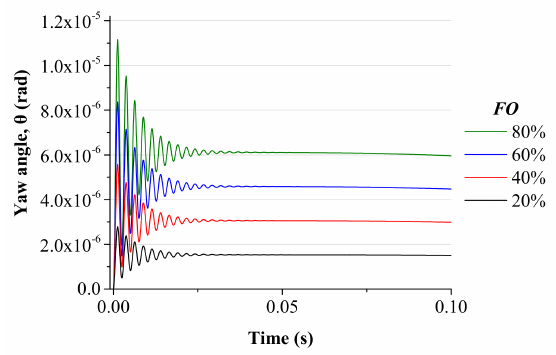
Figure 10. Yaw angle vs. time for various force offsets (No. 4).